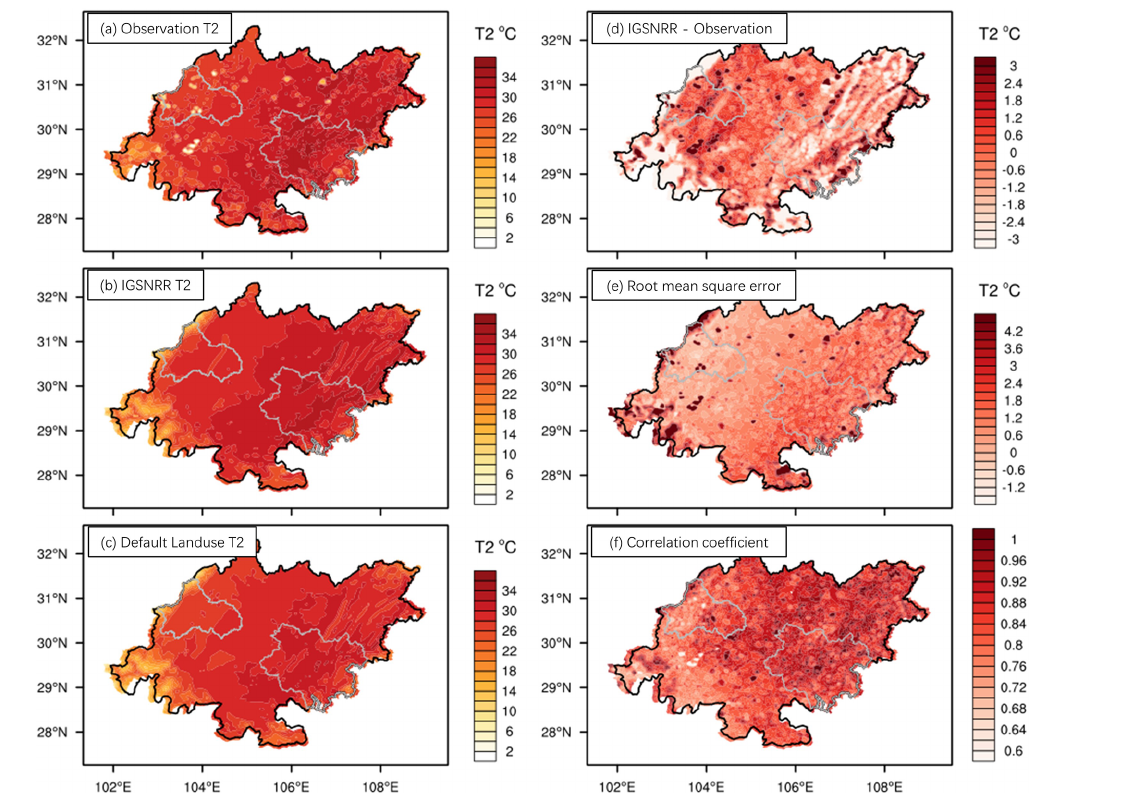
Figure 4. The 2m temperature space distribution of (a) observation data from Cimiss (China Integrated Meteorological Information Service System), (b) simulation results with 2018 land use data from IGSNRR, (c) simulation results with land use data from the WRF default USGS 2010 dataset, (d) simulation of IGSNRR minus observation temperature, (e) root mean square error of 2m temperature between observation and IGSNRR simulation results, and (f) correlation coefficient of 2m temperature between observation and simulation.